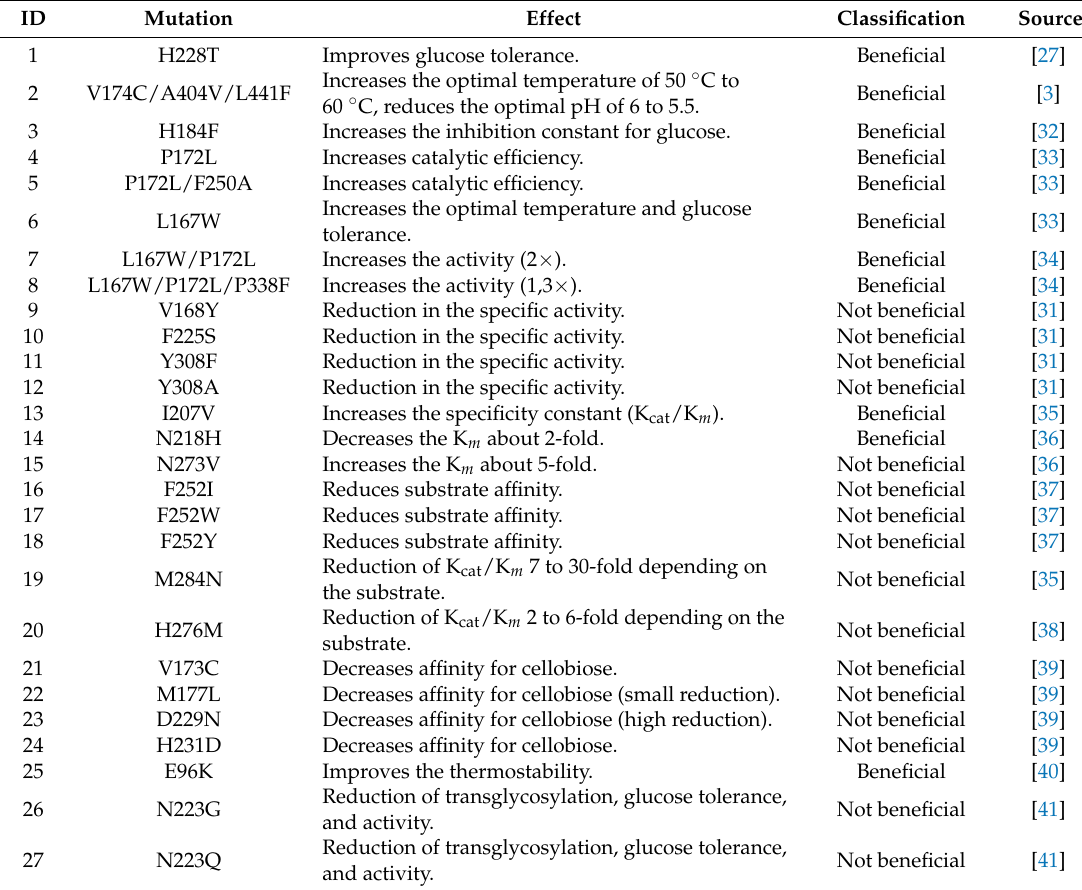
Table 1. Mutations collected from the literature and